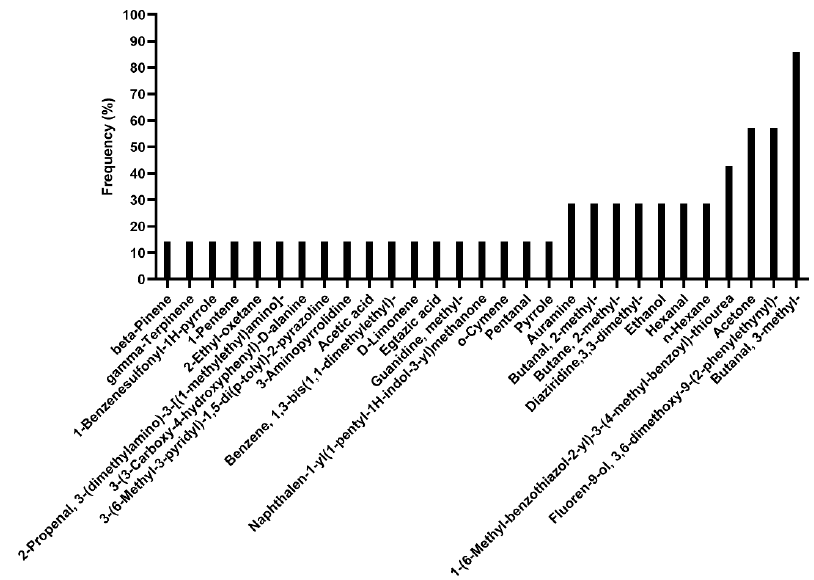
Figure 2. Frequency of VOCs which were detected in semen from the VSR group.